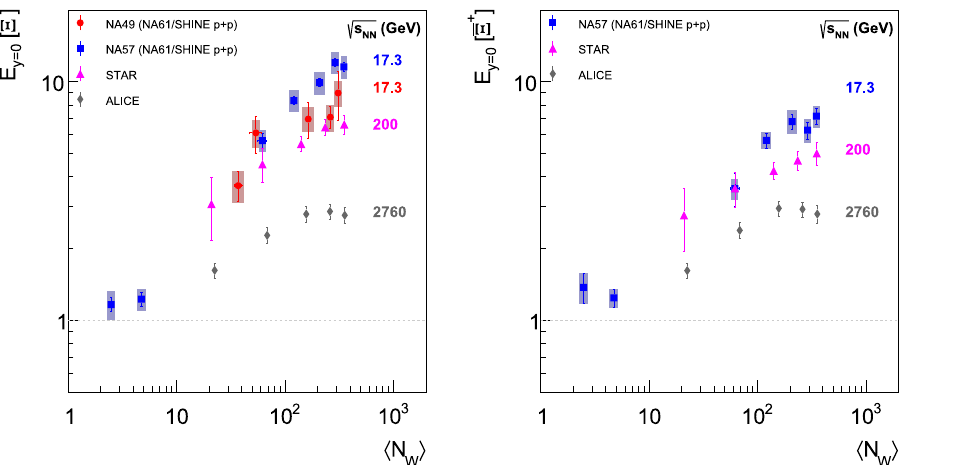
Fig. 7 The strangeness enhancement E at the mid-rapidity as a function of average number of wounded nucleons (cid:2) N W (cid:3) calculated as a ratio of rapidity density for (cid:2) − production ( left ) and (cid:2) + production ( right ) in nucleus-nucleus interactions per (cid:2) N W (cid:3) divided by the corresponding value for p+p interactions. Red circles – NA49 Pb+Pb at 158 A GeV [2], blue squares – NA57 p +Be, p +Pb and Pb+Pb at the same center-of-mass energy √ s The systematic errors are represented by shaded